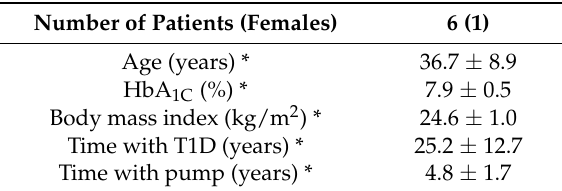
Table 1. Characteristics of the